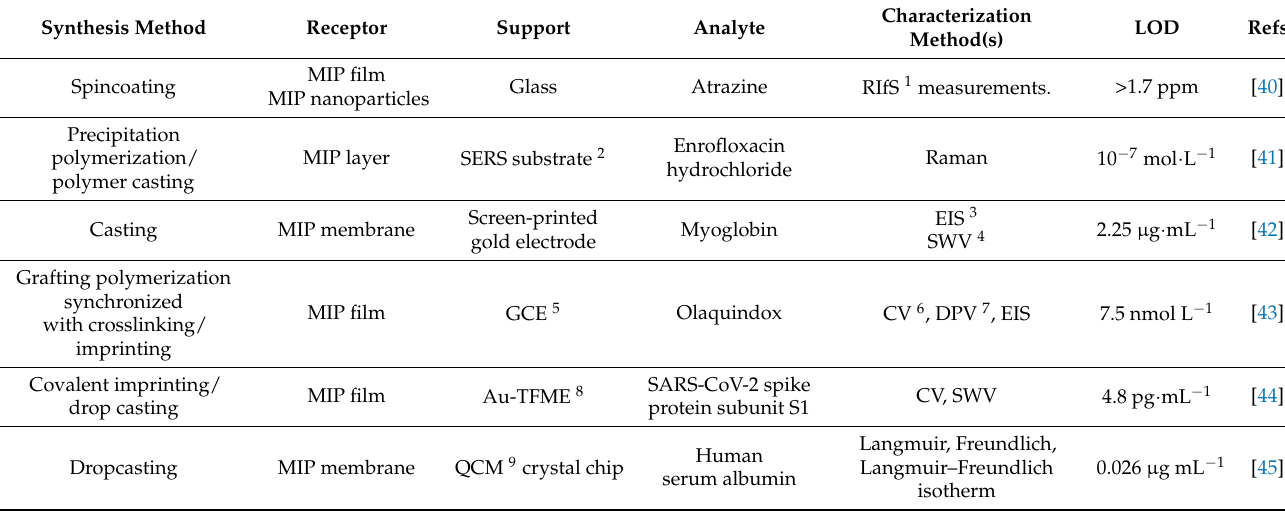
Table 1. MIP-based sensors obtained by surface